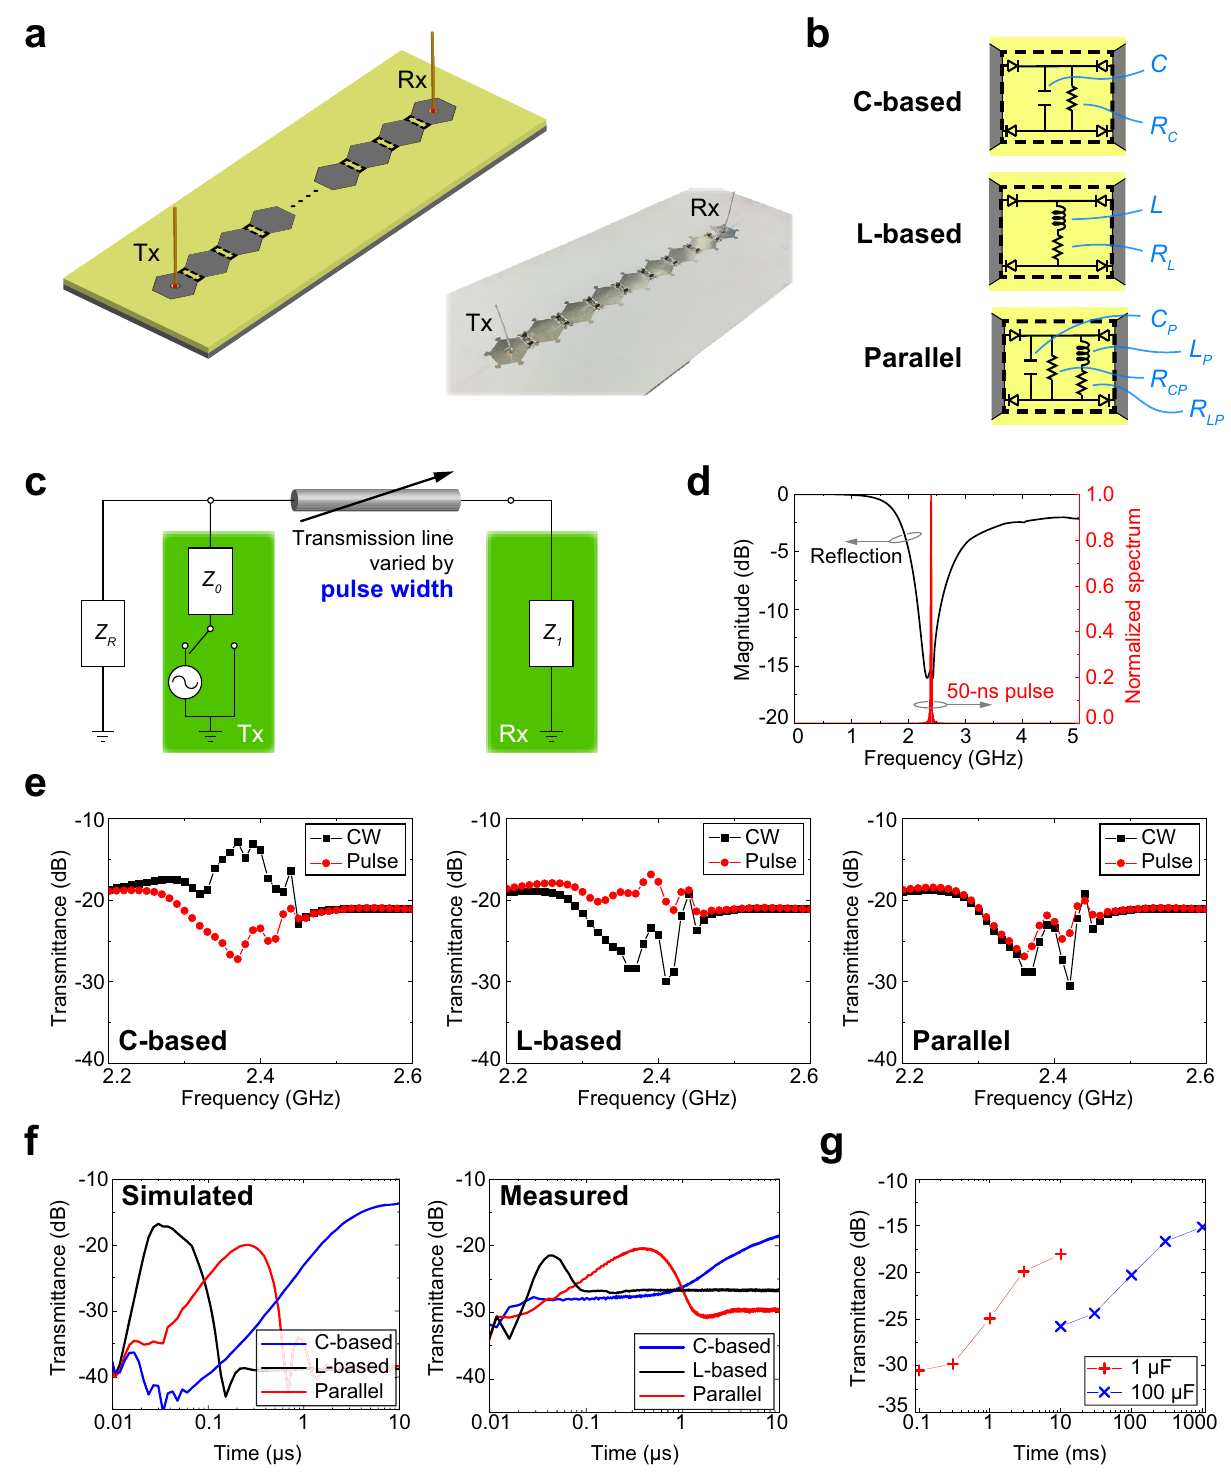
Fig. 1 | Fundamental Single-Line System. a Simulation model and measurement sample. Ordinary grounded monopole transmitters (Tx) and receivers (Rx) were connected by waveform-selective metasurface lines to vary surface wave propa- gation and exhibit ultratransient responses at the same frequency. b Circuit con- fi gurations for C-based, L-based and parallel waveform-selective metasurfaces. DesignparametersareseeninSupplementaryFig.S1,SupplementaryTablesS1and S2. c Simpli fi ed equivalent circuit concept representing the two monopole anten- nas(TxandRx)connectedbythewaveform-selectivemetasurfaceline. d Simulated re fl ectance of the monopoles and normalized spectrum of a 50-ns sine wave pulse of 2.42GHz. e Simulated transmittances between the antennas connected by (left)